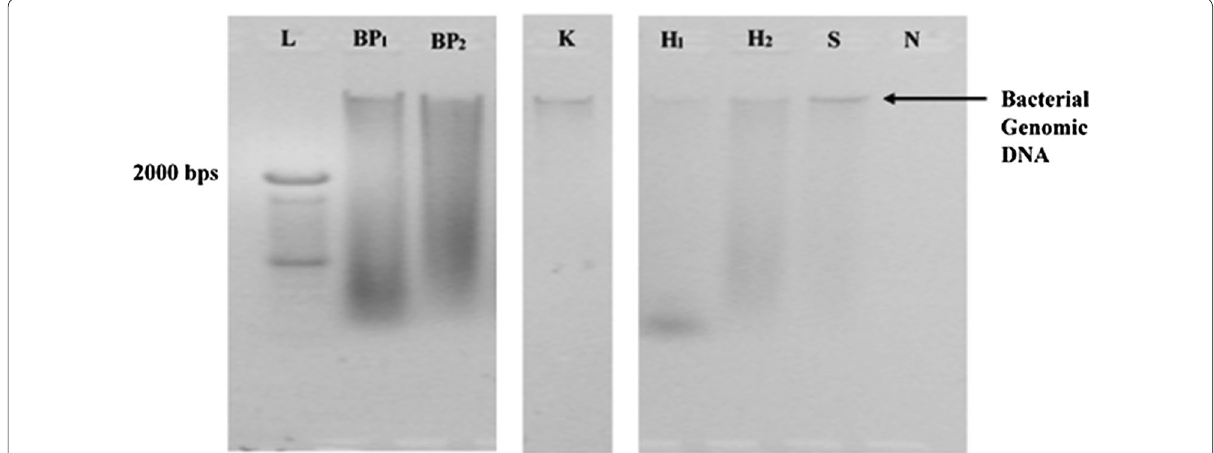
Fig. 1 The quality of DNA extracted from wound tissue debridement specimen No. 1 using six DNA extraction